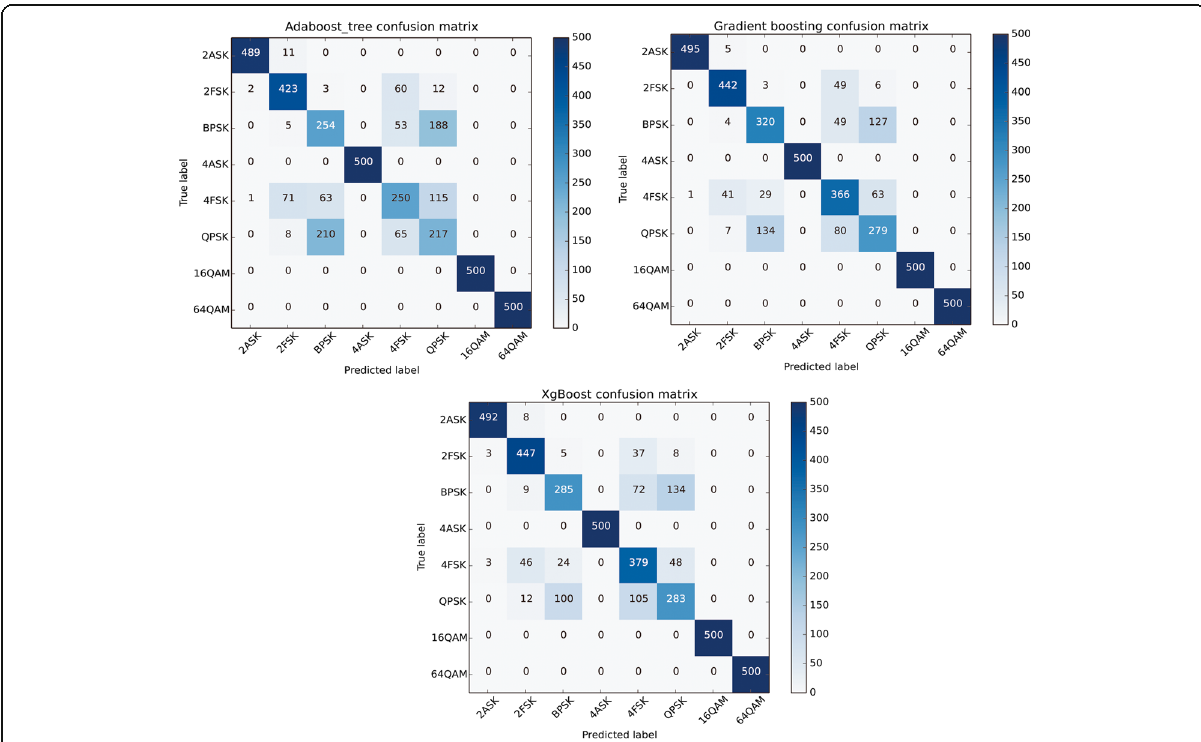
Fig. 5 Recognition confusion matrix of AdaBoost, gradient boosting decision tree, and xgboost algorithm versus SNR = − 10 dB, tree depth is